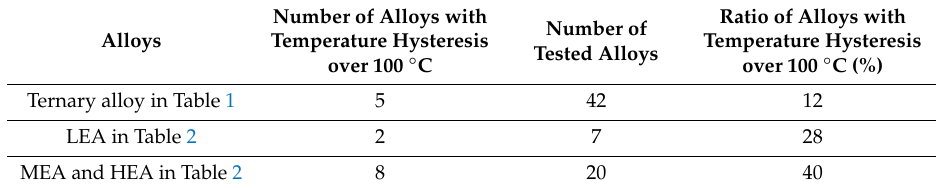
Table 3. Ratio of alloys with temperature hysteresis over 100 ◦ C